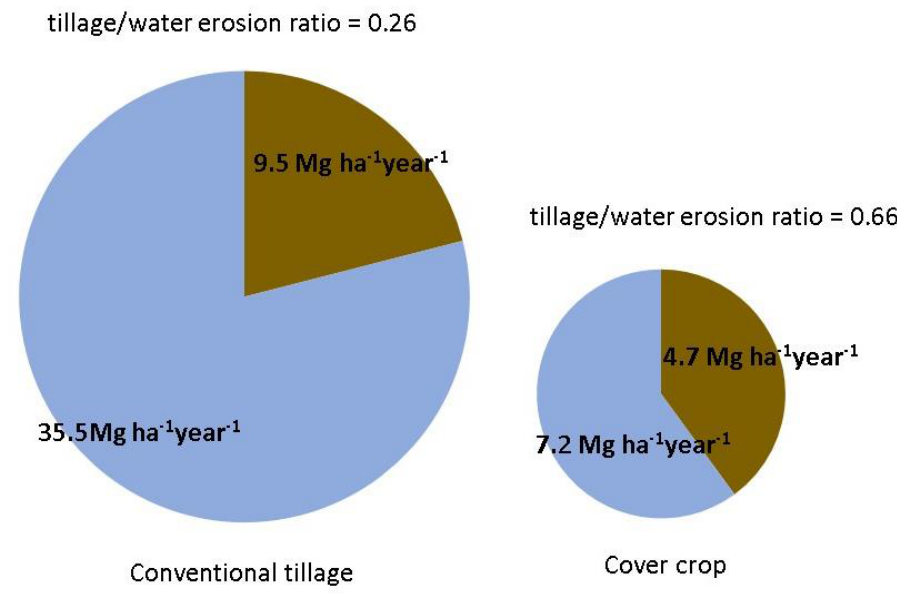
Figure 4. Comparison between (brown area) tillage erosion and (blue area) water erosion in the studied vineyard under conventional tillage soil management and a hypothetical cover crop soil management.